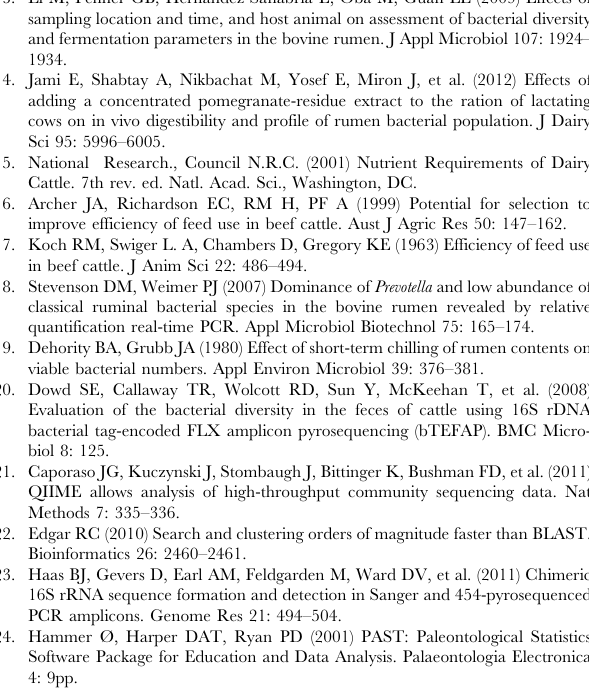
Table S1 Formulated ingredients in g/kg dry matter (DM) of the basic total mixed rations given to lactating dairy cows. Table S2 Production parameter values and SEM for each individual cow. Table S3 Length and number of reads per animal sampled after quality filtering and removal of chimeric sequences and singletons-